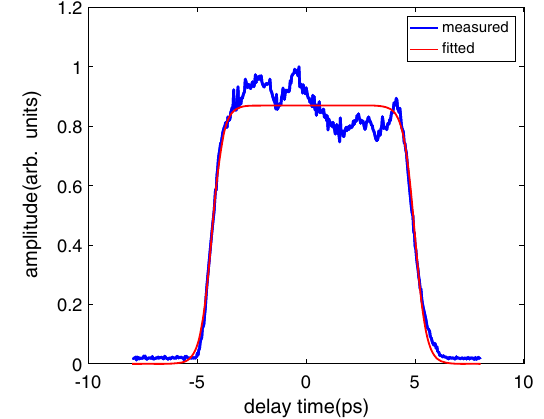
FIG. 2. Measured and fitted temporal profile of the UV laser.